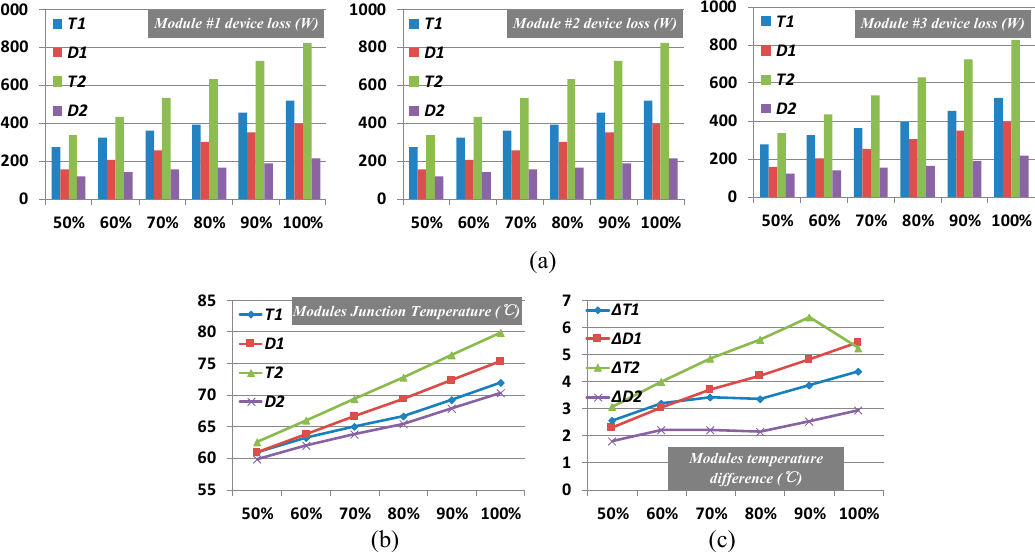
Figure 10. Thermal results of the modules without obvious circulating current flowing: ( a ) three module device losses; ( b ) junction temperature; and ( c ) junction temperature differences.